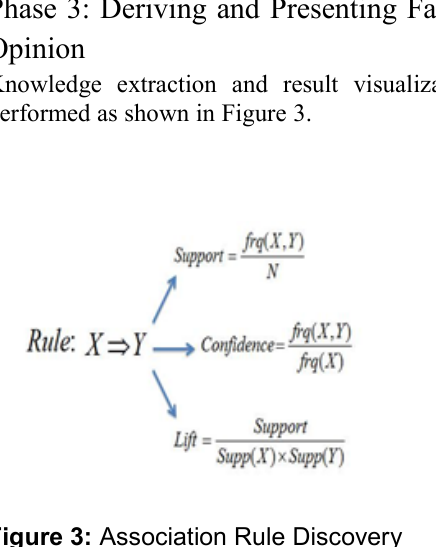
Figure 3: Association Rule